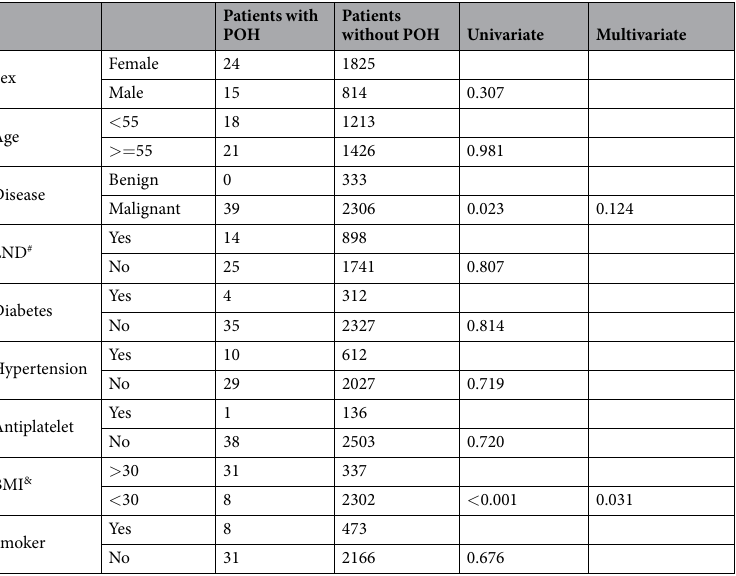
Table 3. Risk factor analysis of POH * . * POH: Postoperative hematoma; # LND: Lateral neck dissection; & BMI: Body Mass Index.